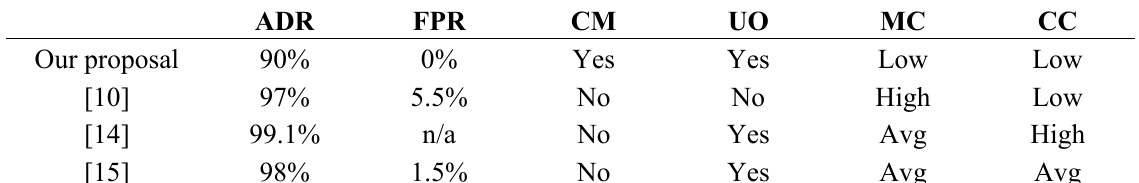
Table 2. Comparison among different RPW acoustic detection